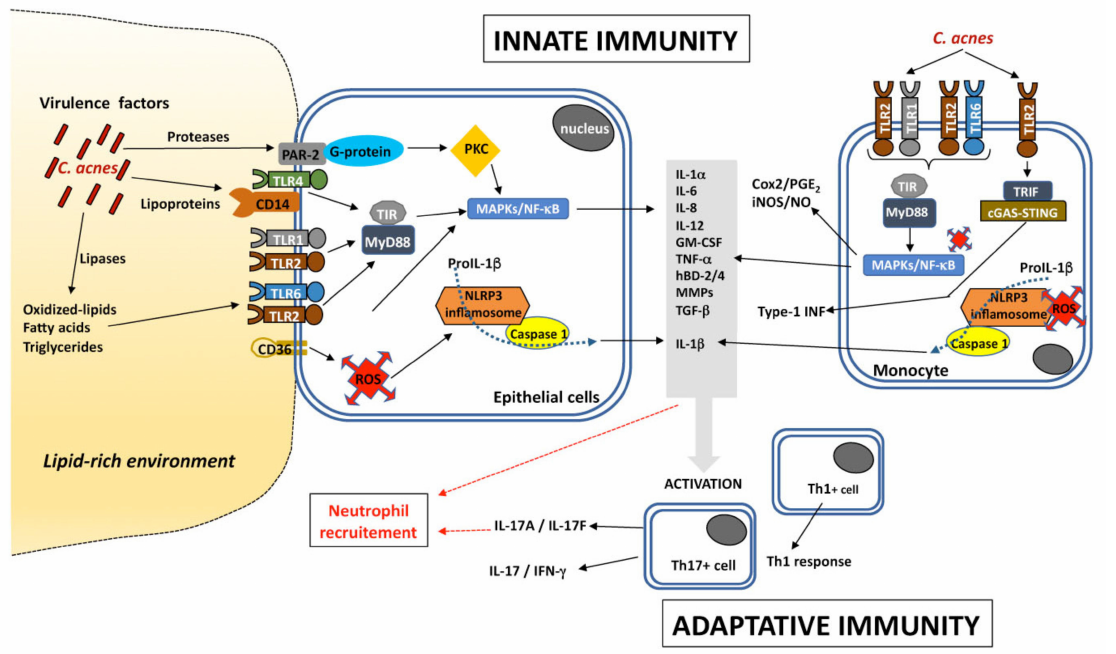
Figure 2. Inflammatory pathways induced by C.